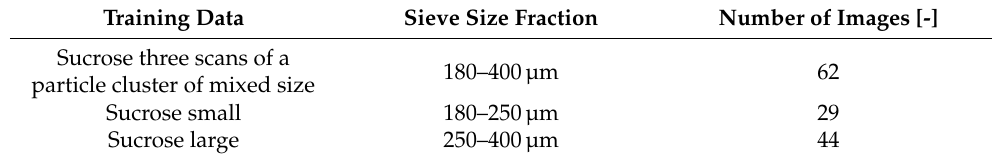
Table 4. Training data set of Sucrose particle species and their amount and sieve size